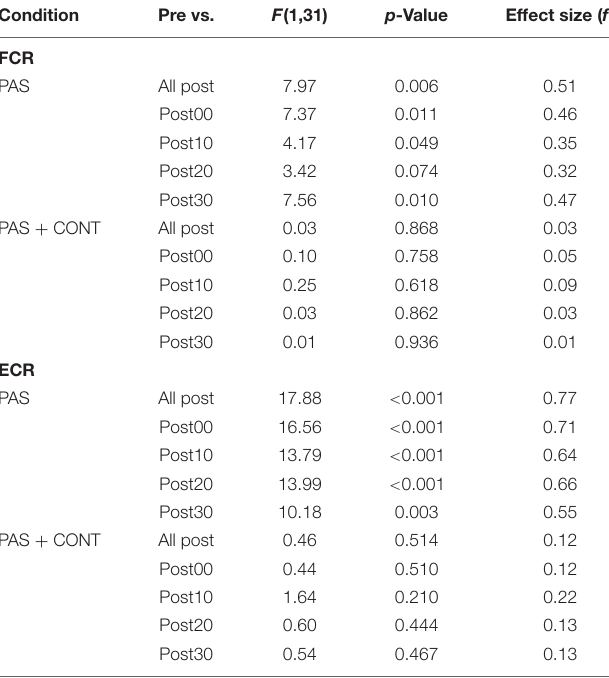
TABLE 3 | Stroke survivors: F ratios, p -values and (unbiased) effect sizes for comparisons between the MEP amplitudes obtained prior to the intervention